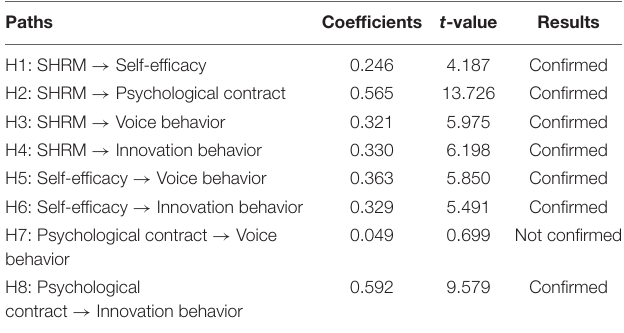
TABLE 2 | Results of the hypotheses testing.